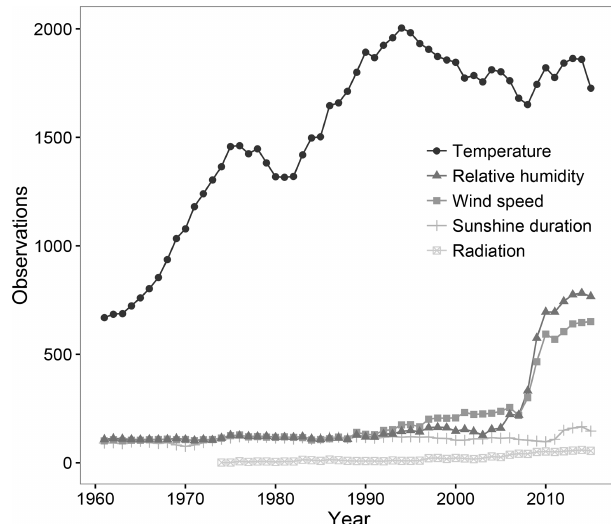
Figure 1. Temporal evolution of the data